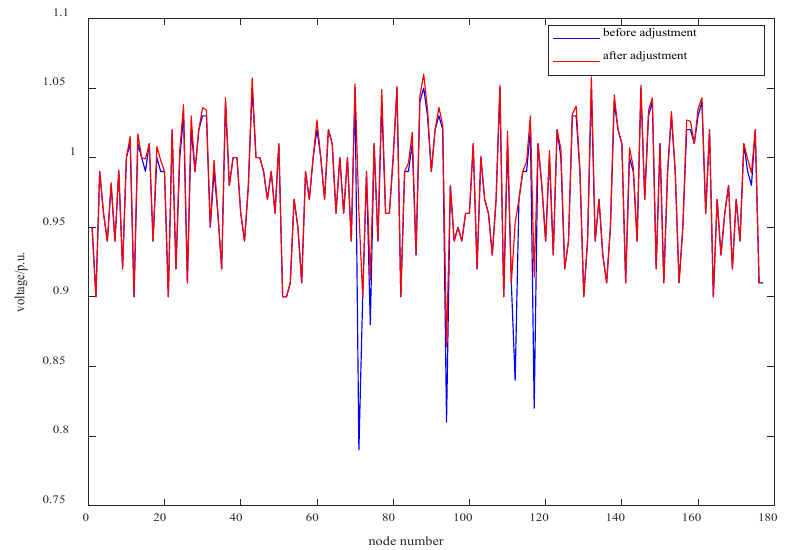
Figure 11. Voltage before and after adjustment.